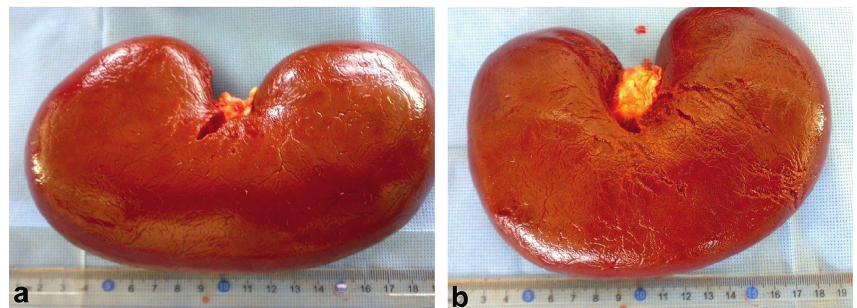
Figure 1: Right (a) and left (b) kidneys in an adult camel (both with removed renal capsules).